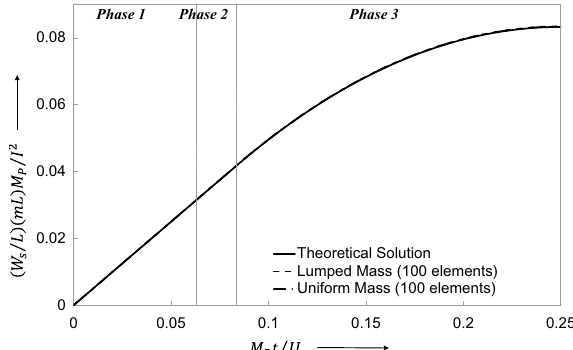
Figure 20. Comparison of beam central displacement changing over time from the start till the standstill.